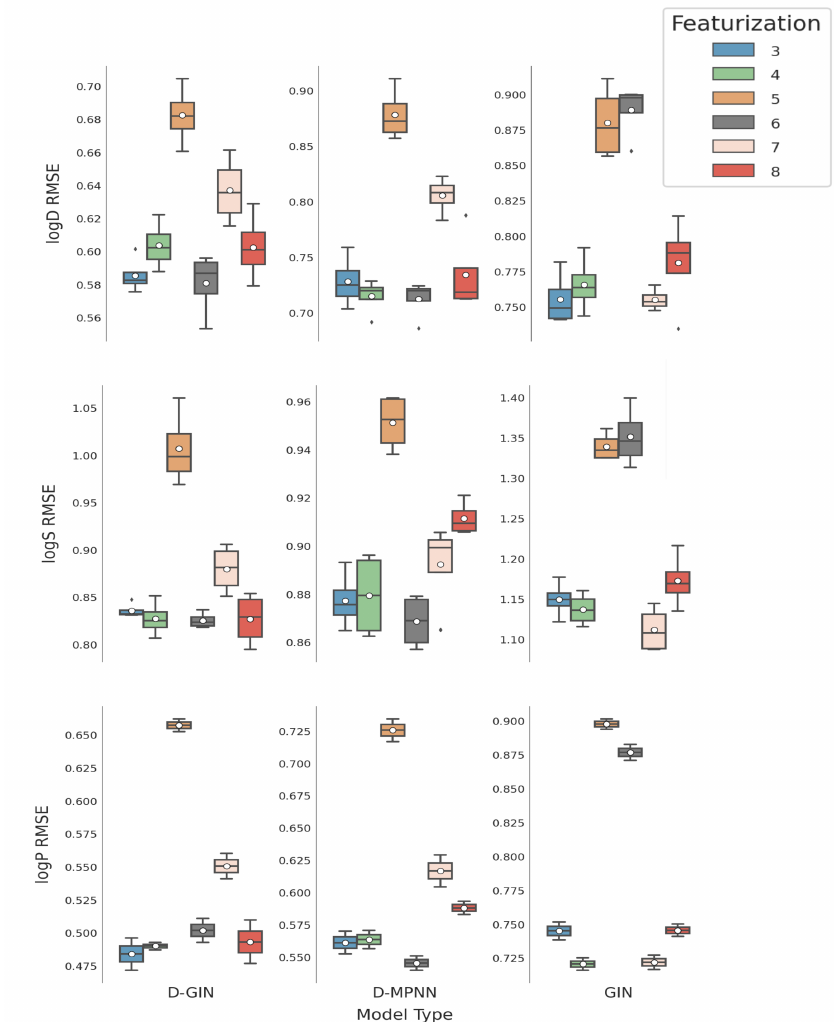
Figure 6. LogD, logS, and logP prediction results for all GNN model types depending on the featurization used (see Section 2.4 for a detailed description). The mean is shown as a white dot whereas the median is shown as a dark gray line. Exact values are listed in Tables A8–A19 in the Appendix